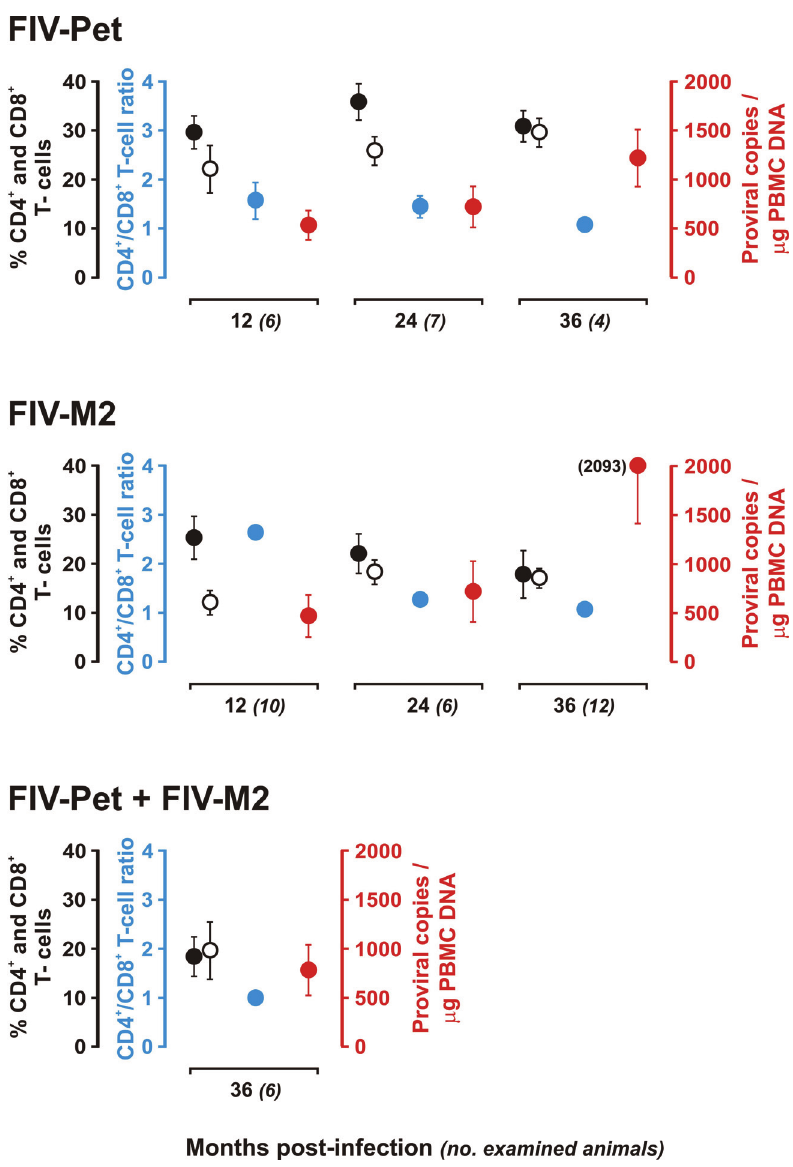
Figure 1. Analysis of CD4 + and CD8 + T-cell levels and proviral load in the peripheral blood of the examined cats at different times from infection. Solid and empty black circles indicate percent of CD4 + and CD8 + T-cells, respectively. Light blue circles indicate the CD4 + and CD8 + T-cell ratio that was calculated by dividing the CD4 + value by the CD8 + value. Red circles indicate the proviral load expressed as numbers of proviruses per µg of PBMC DNA and determined by competitive or real-time PCRs. The proviral load values for FIV-Pet + FIV-M2 cats are the total number of FIV-Pet and FIV-M2 proviral genomes. Whiskers indicate the standard